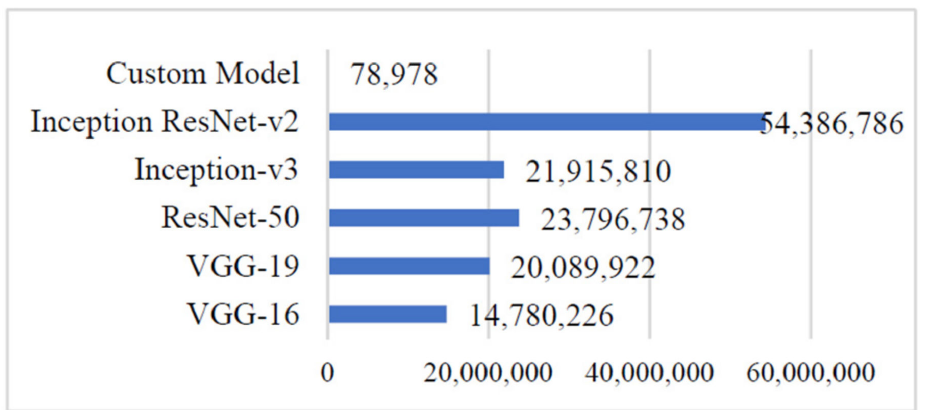
Figure 12. Training parameters of different deep learning